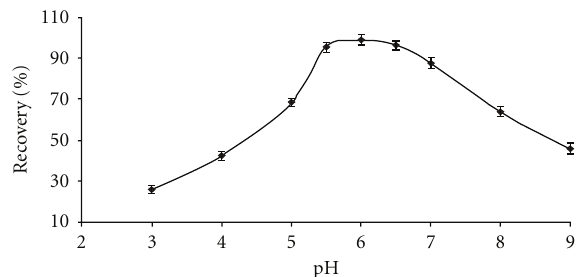
Figure 1: E ff ect of pH on the recovery of lead. Conditions: Pb(II), 2.5ng; bu ff er, 2 mL; NaCl 10% (w/v), 1mL; MIONs, 100 mg; sam- ple volume,